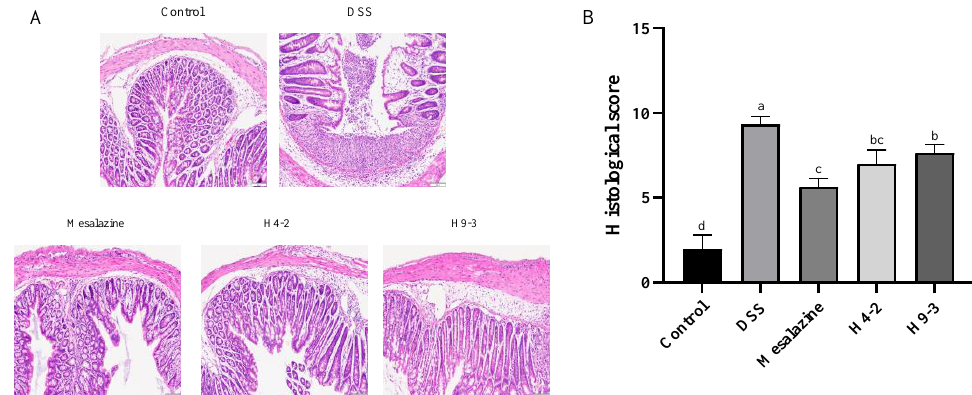
Figure 3. Effects of B. breve intervention on mice colon histological sections of H&E staining ( A ) and histopathology scores ( B ). Different lowercase letters (a, b, c, d) above the columns indicate significant differences ( p < 0.05), and the same superscript letters indicate that the differences between the values are not statistically significant ( p > 0.05).